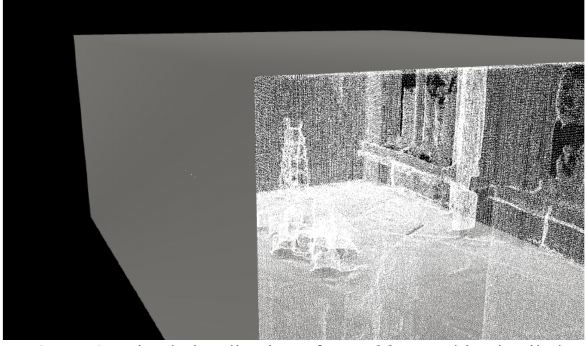
Figure 3. Mixed visualization of a Building and its detailed interior as BuildingPart (417.138 points)